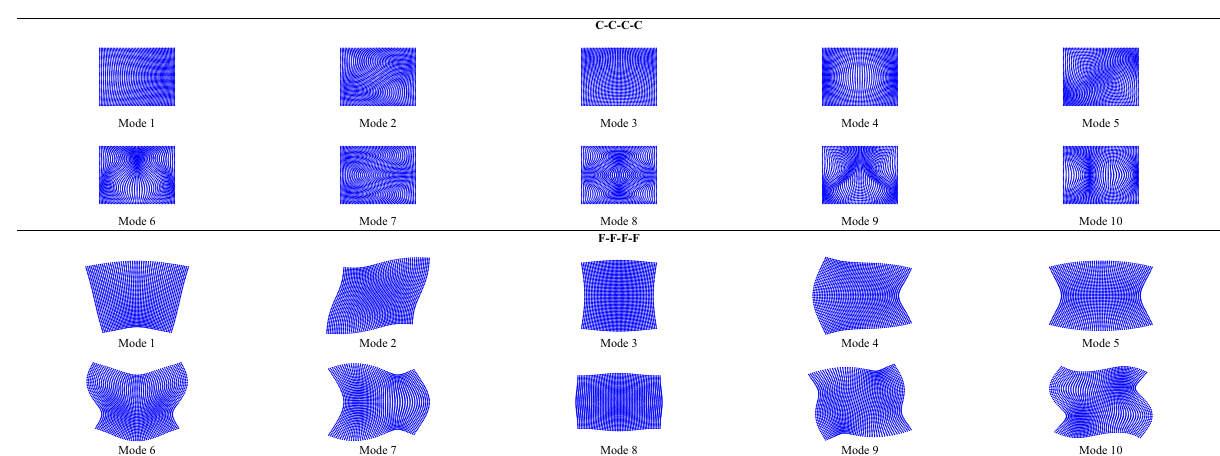
E x = 2.5 and ν x ν y = ( 0.3 ) 2 (cid:31)